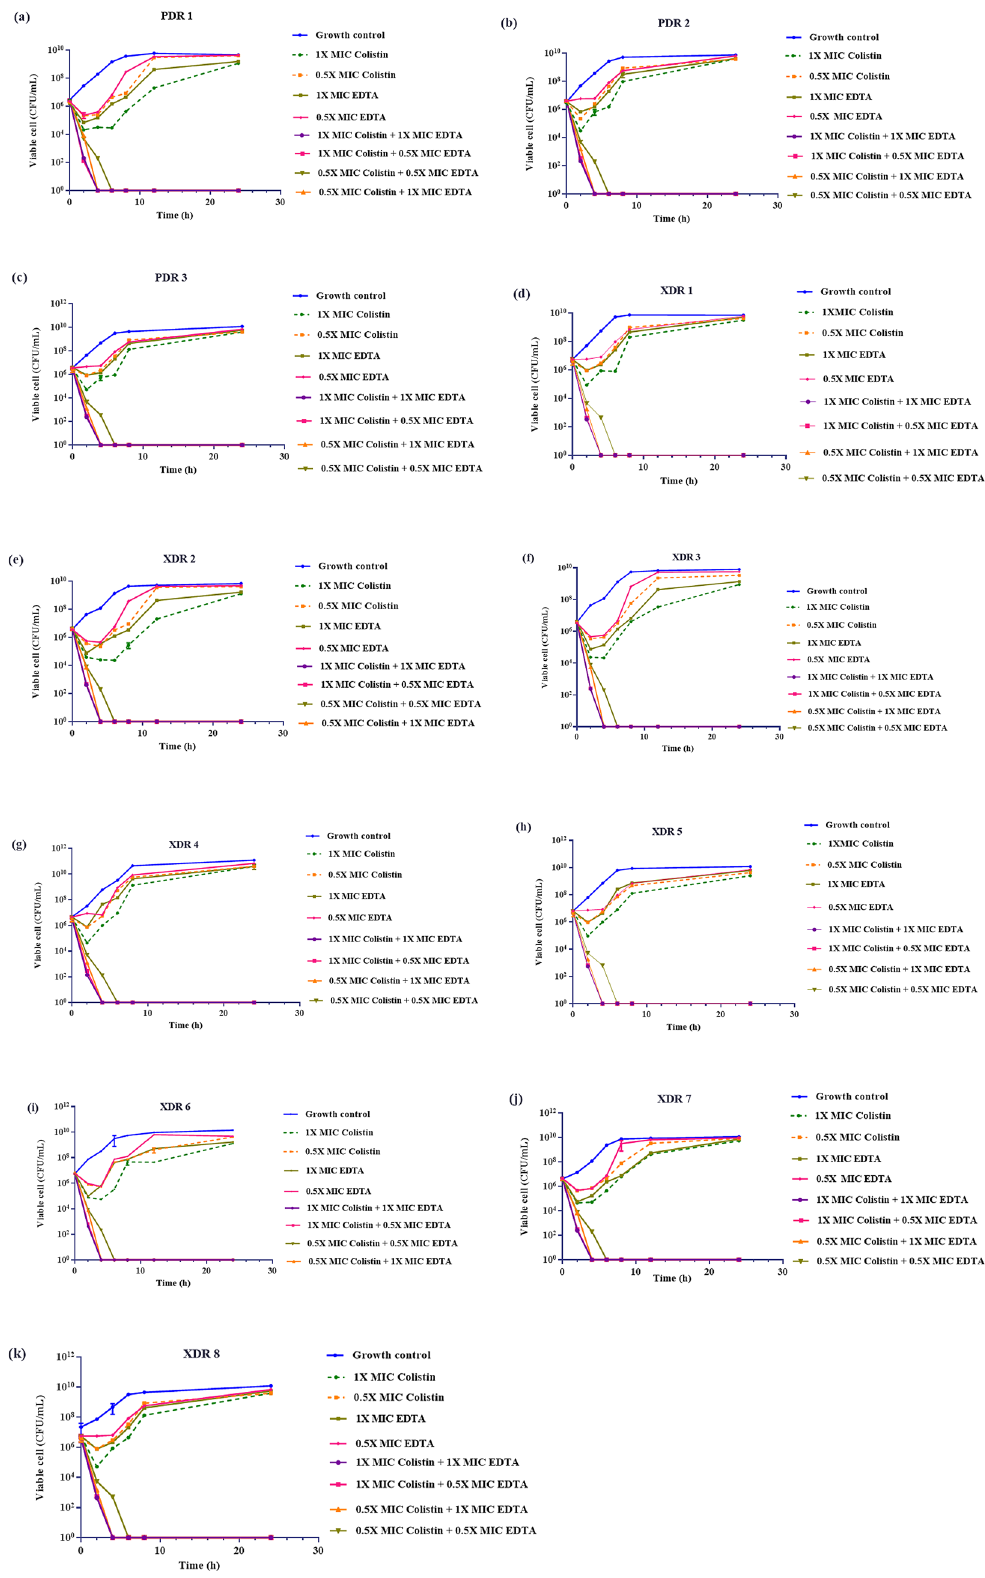
Figure 6. Time-kill effects of single and combination of colistin and EDTA on 11 representative PDR and XDR ColRKp clinical isolates with plasmid-mediated and chromosomal mgrB or pmrB or phoP -mediated colistin- resistant